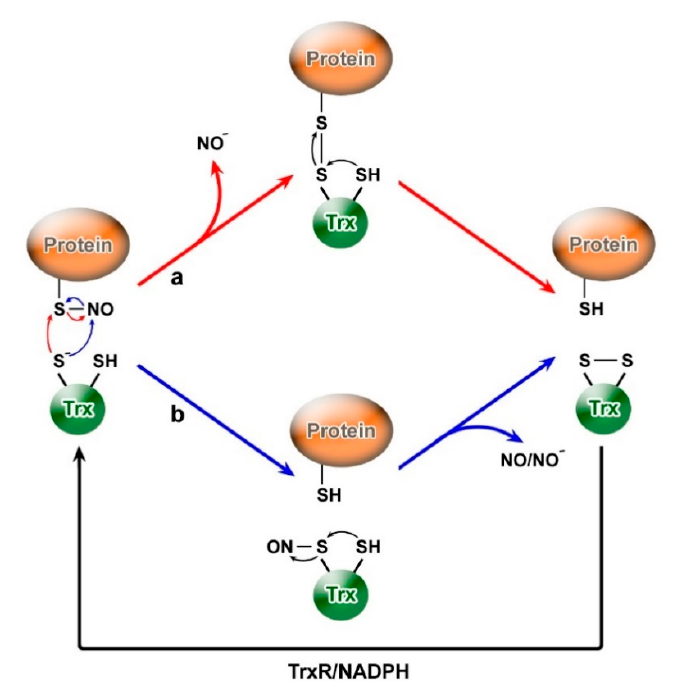
Figure 2. Protein denitrosylation by the Trx/TrxR system. Two thioredoxin-dependent mechanisms of protein denitrosylation are proposed: (a) formation of Trx linkage with substrate protein by a disulfide bridge; (b) trans-nitrosylation due to transient S-nitrosylation of Trx. A wide range of substrates have been identified for denitrosylation catalyzed by Trx.